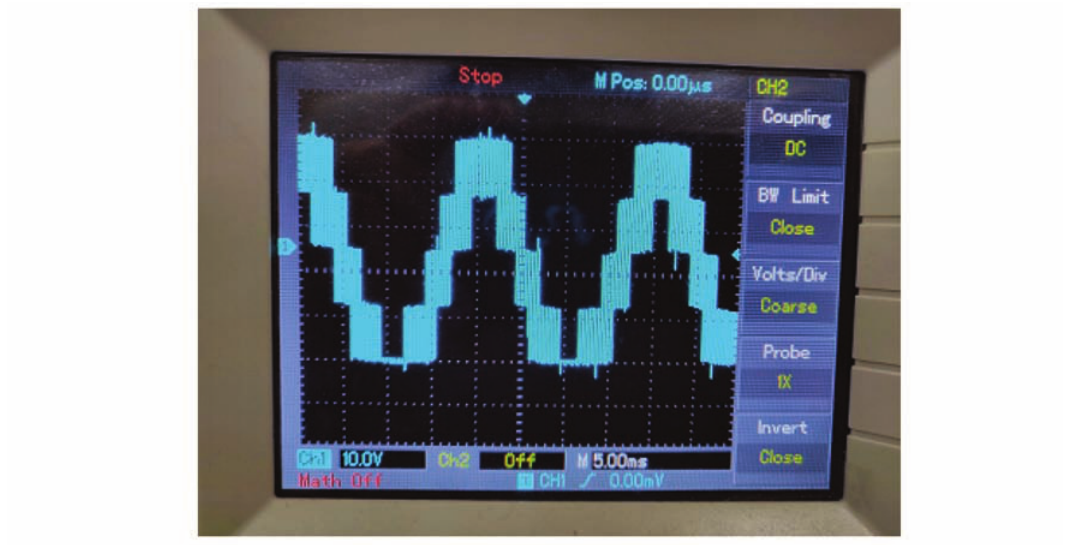
g. 16. Circuit diagram of the gate drive circuit generated by electronic design automation software. Fi Fig. 18. Generated voltage in Phase A without aa